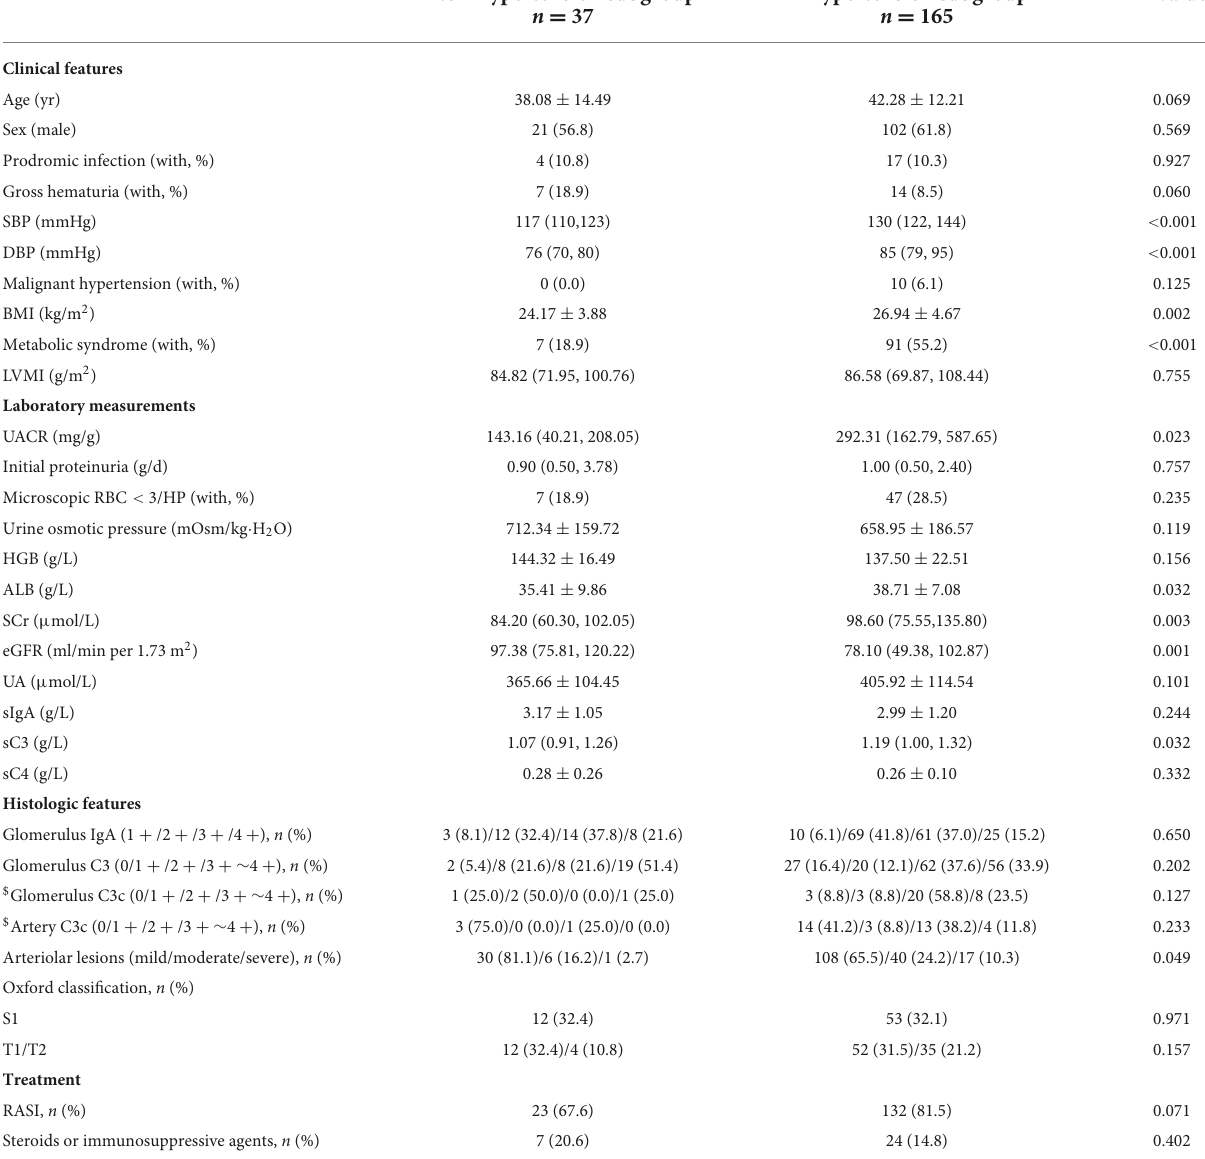
TABLE 3 Demographic, clinical, and histologic characteristics of hypertension and non-hypertension subgroup in arteriolar lesions group of IgAN patients.